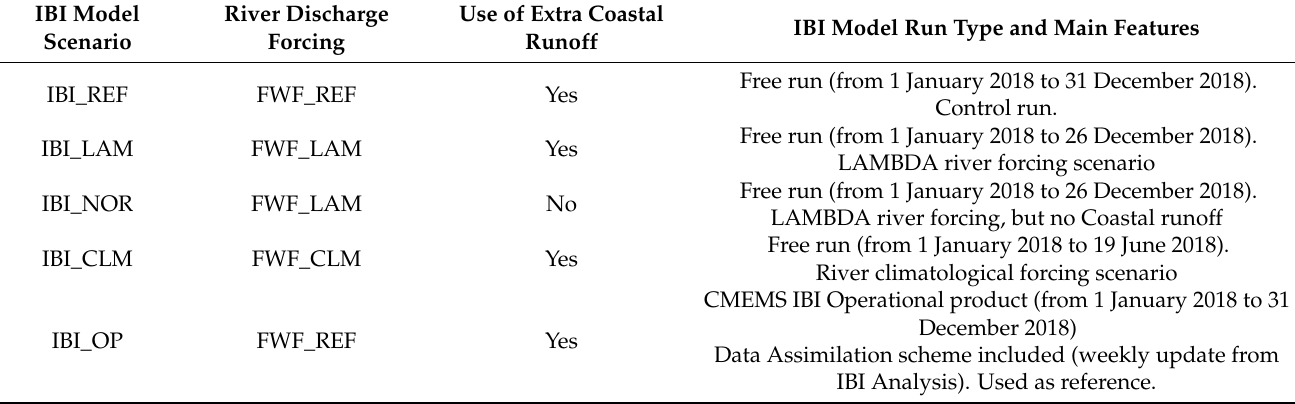
Table 4. IBI model scenarios: Overview of model runs with each specific treatment of river and coastal freshwater in- puts .